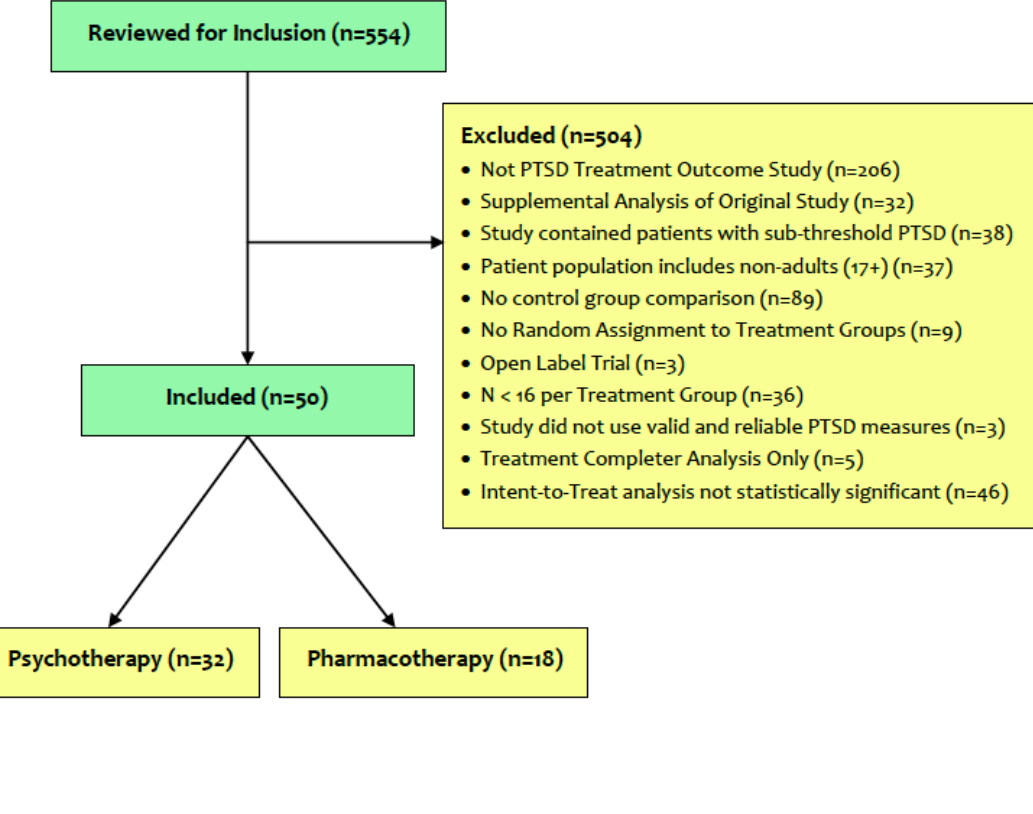
Figure 1. CONSORT diagram of eligible studies for inclusion in the